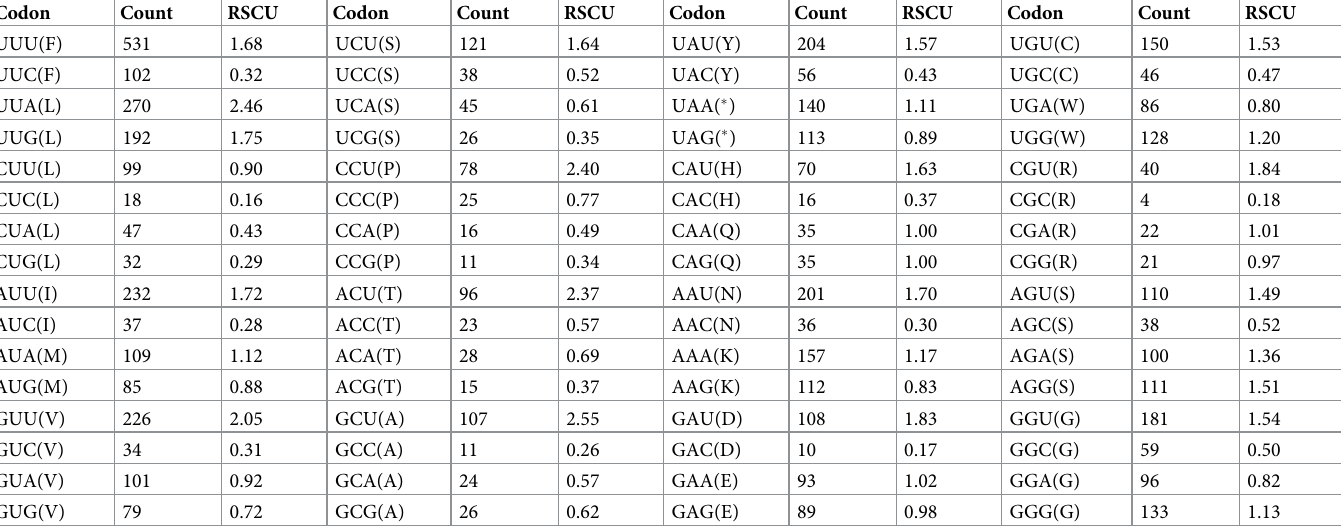
Table 5. The codon number and relative synonymous codon usage in the mitochondrial genomes of S . minima